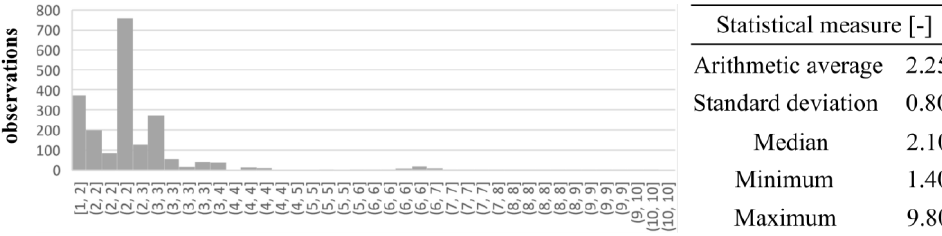
Figure 20. A histogram of the HDOP with the sample statistical parameters .